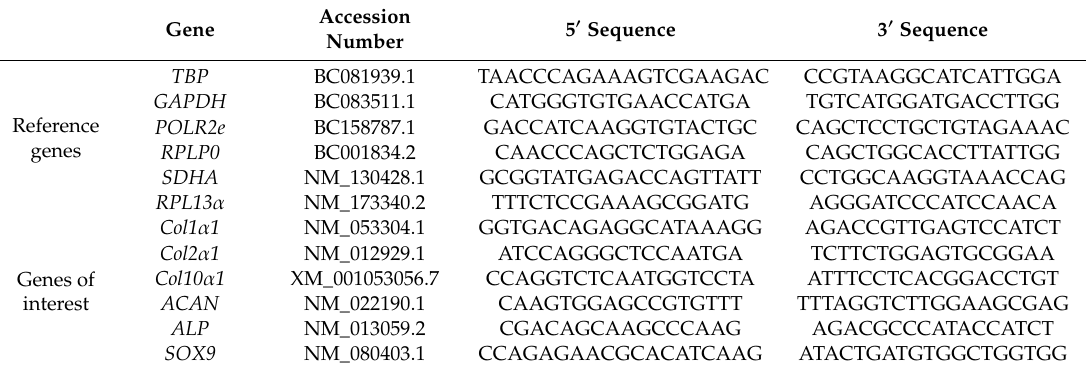
TBP: TATA-binding protein, GAPDH: Glyceraldehyde 3-phosphate dehydrogenase, POLR2e: RNA polymerase II subunit e, RPLP0: Ribosomal protein lateral stalk subunit P0, SDHA: Succinate dehydrogenase complex